Question: Sum up the contents of this chart in one sentence.
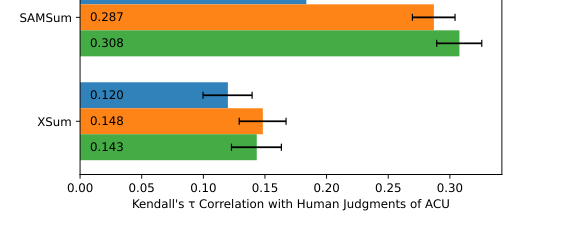
Answer: Performance Comparison on the RoSE benchmark. Our approach performs statistically signif- icantly better than the SOTA LLM-evaluator for summa- rization (Chiang and Lee, 2023) on the CNNDM dataset partition, and significantly better than G-Eval on both CNNDM and SAMSum. Confidence intervals are com- puted through bootstrap sampling.